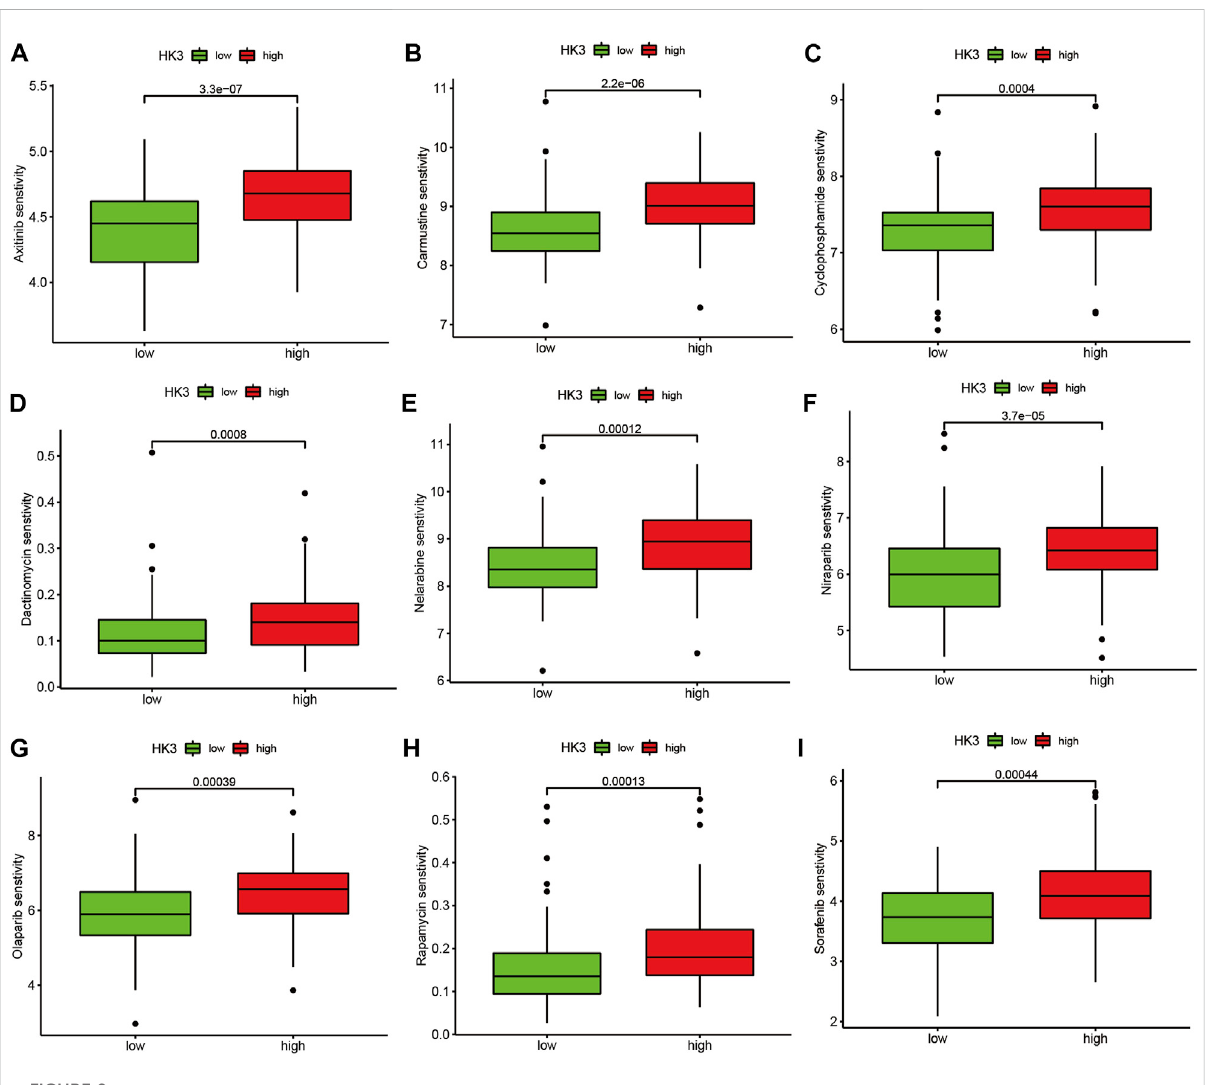
FIGURE 9 Drug sensitivity analysis. Comparison of the IC50 value of drugs between the high and low HK3 expression groups in the TCGA cohort. (A) Axitinib, (B) Carmustine, (C) Cyclophosphamide, (D) Dactinomycin, (E) Nelarabine, (F) Niraparib, (G) Olaparib, (H) Rapamycin, (I)